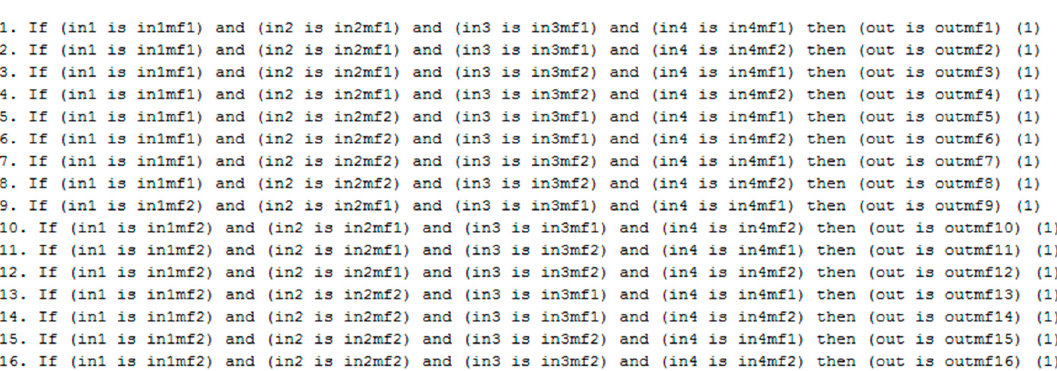
Figure 6. Inverted pendulum system.